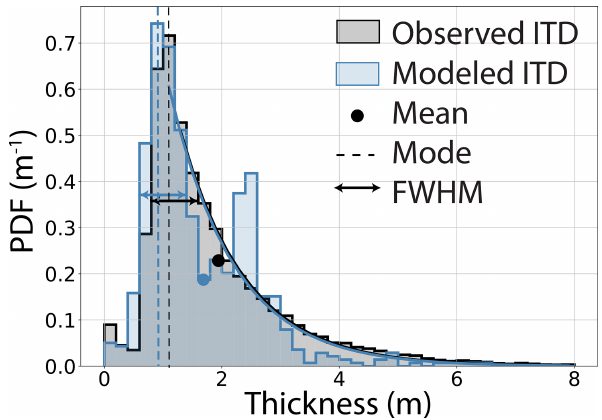
Figure 9. Observed and modeled ITD with mean (dot), exponential fit to the tail of the distribution, and FWHM (horizontal